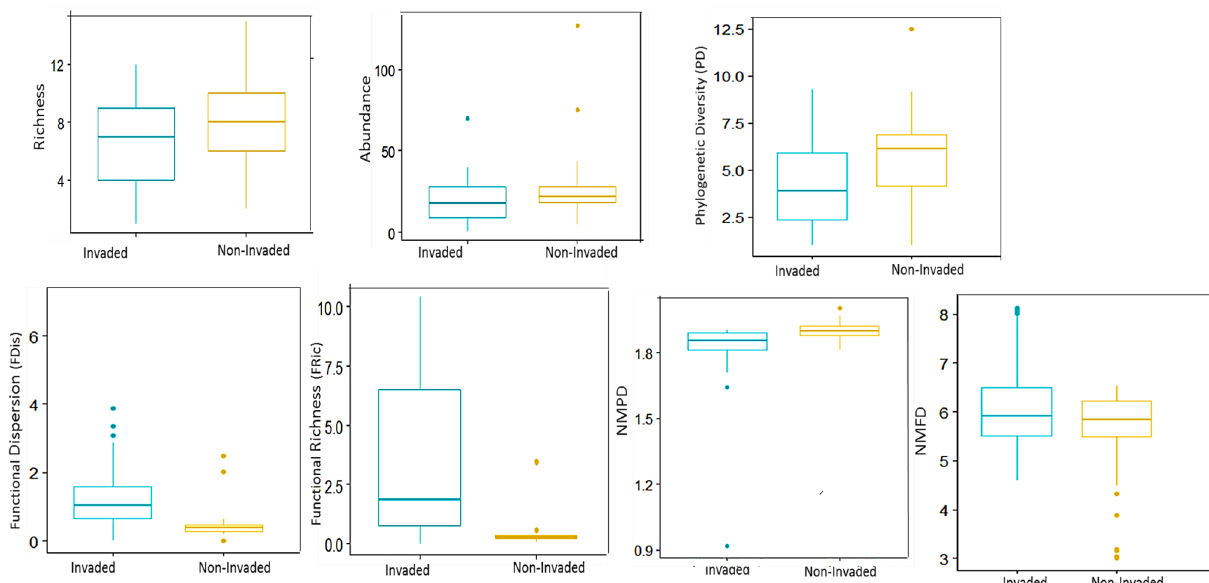
Figure 1. Mean differences in the native richness and abundance, phylogenetic Diversity (PD), Functional Dispersion (FDis), Functional richness (FRic), Native phylogenetic relatednes (NMPD), Native functional relatedness (NMFD) between invaded plots and non-invaded